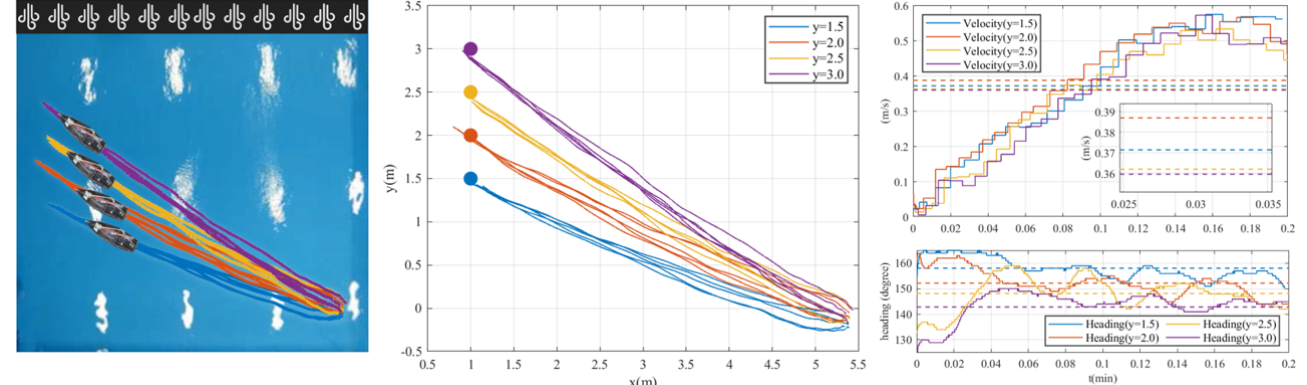
Figure 13. Remote algorithm deployment (PID) about sailing testing in STAr. The test is performed by using different given points (x = 1.0; y = 1.5 2.0 2.5 3.0). The left picture shows the path and wind direction in real test environment. To distinguish different target point, The blue, red, orange and purple represents the above given tests, respectively. The middle figure is the path of the sailboats and their target points. The right figures are velocity and heading versus time, and the dotted lines represent the average velocity and